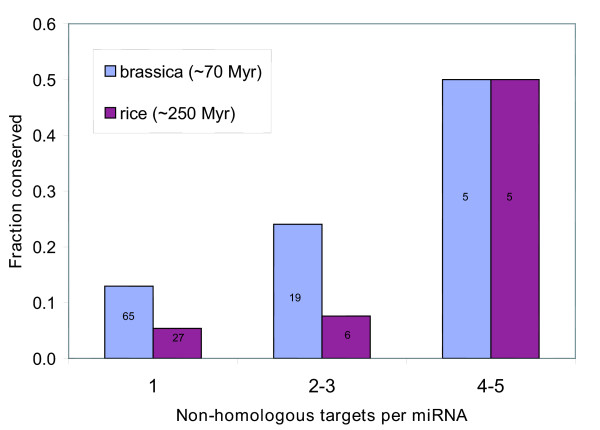
Multi target predictions tend to be better conserved. The precursor sequences of the predictions were used as queries for a blast search against rice (downloaded from tigr.org, March 2004) or brassica (downloaded from arabidopsis.org, August 2004), respectively. Columns show the proportion of miRNA predictions in Arabidopsis that were found to be conserved. Numbers refer to the actual number of conserved miRNA predictions.